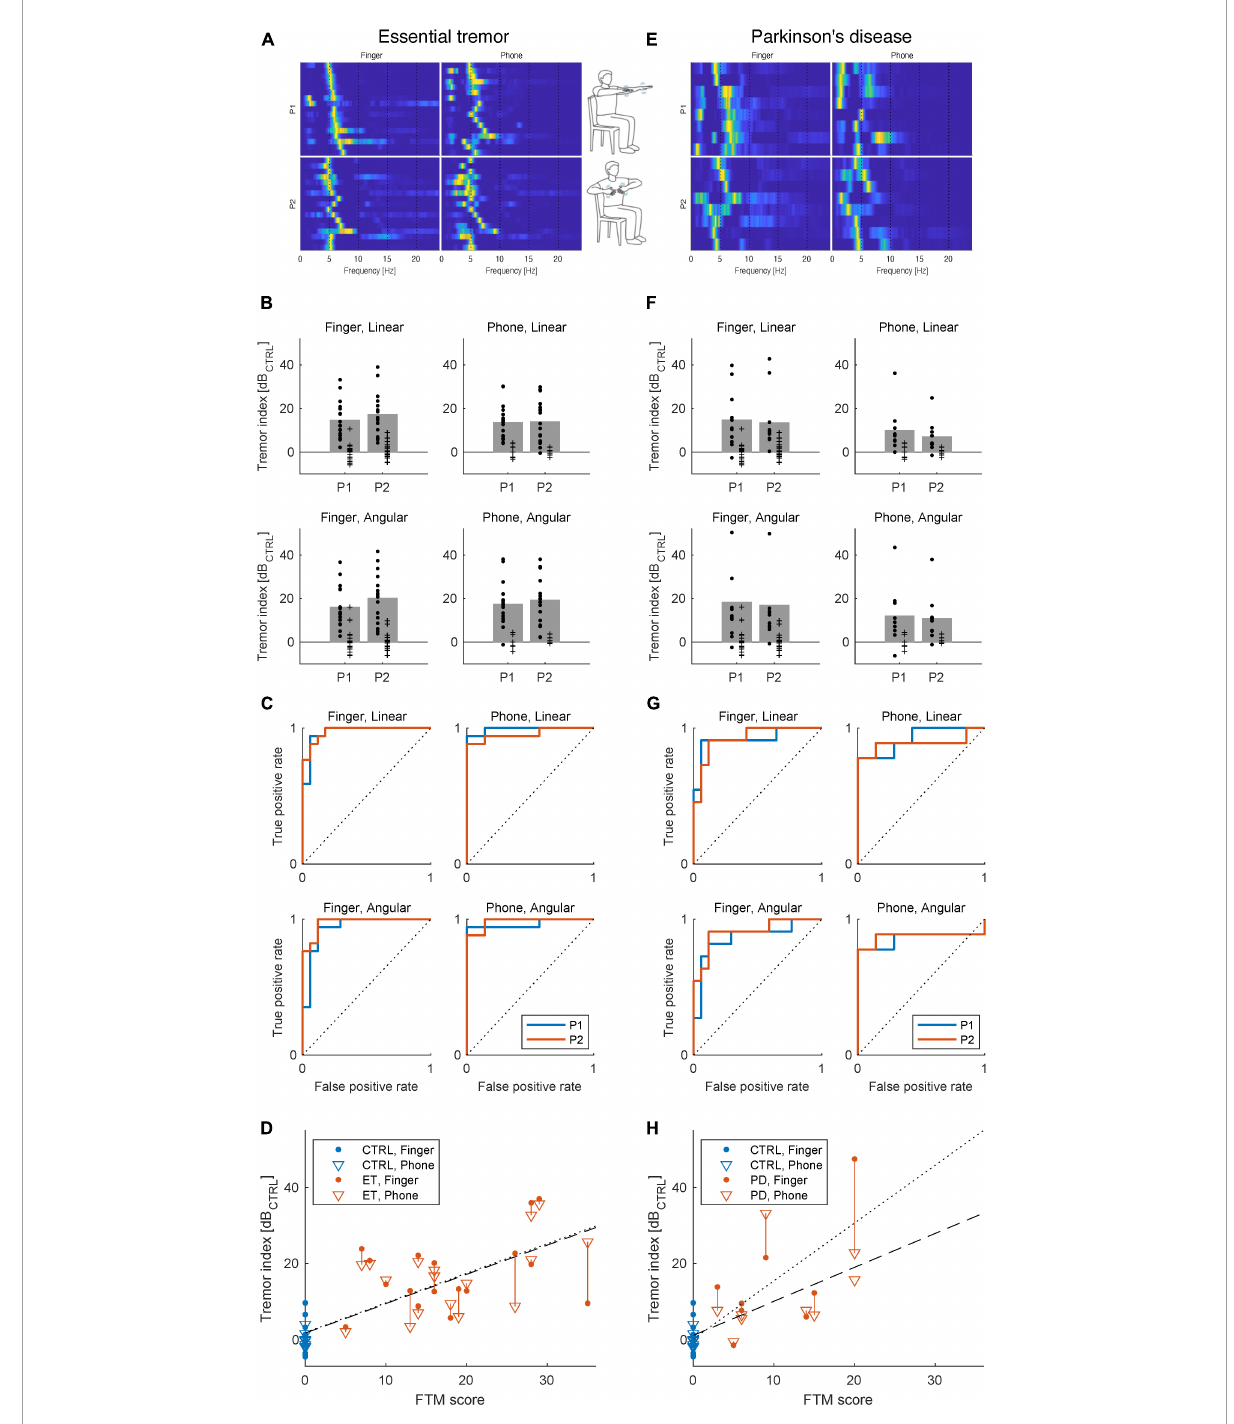
FIGURE2 Characterization of postural tremor in ET (A–D) and PD (E–H) using smartphone or finger-attached sensors. (A) Postural tremor recorded using high-resolution inertia sensor attached to the index finger (leftmost column) or smartphone (right). Each line illustrate the relative power spectral density of tremor frequencies in the range 1–20 Hz for one of the 17 ET patients (the 17 patients displayed in each panel were ordered according to each individual’s dominant tremor frequency in Position 1 (P1) using the finger sensor). (B) Tremor patterns differ between ET patients and the control group resulting in differences in calculated indices (Rows: linear/angular and Columns: Finger/smartphone sensors). Bars denote means scores above the control group average for the ET patients in the respective conditions and each dot represent one subject (crosses represent control group). (C) Receiver operating characteristic curves illustrating classification performance for each data type. (D) Correlation of tremor index to clinical FTM scores. The dotted and dashed lines are the least-squared fits to the Finger and Phone